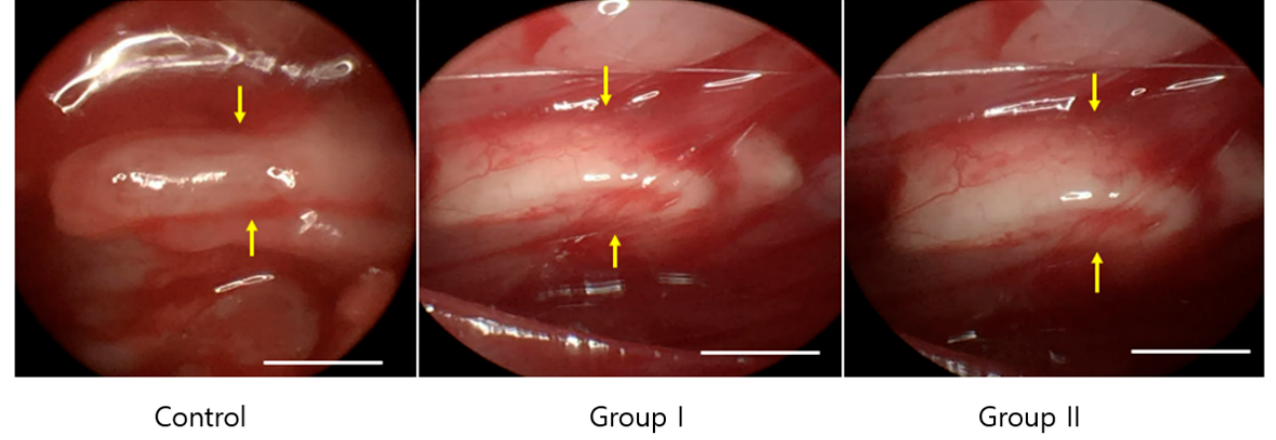
Figure 5. All groups show well-regenerated nerve. Compared with the control group, both the mesenchymal stem cell (MSC) and pre-induced MSC groups show slightly larger diameter of the nerve, but the difference was not significant.